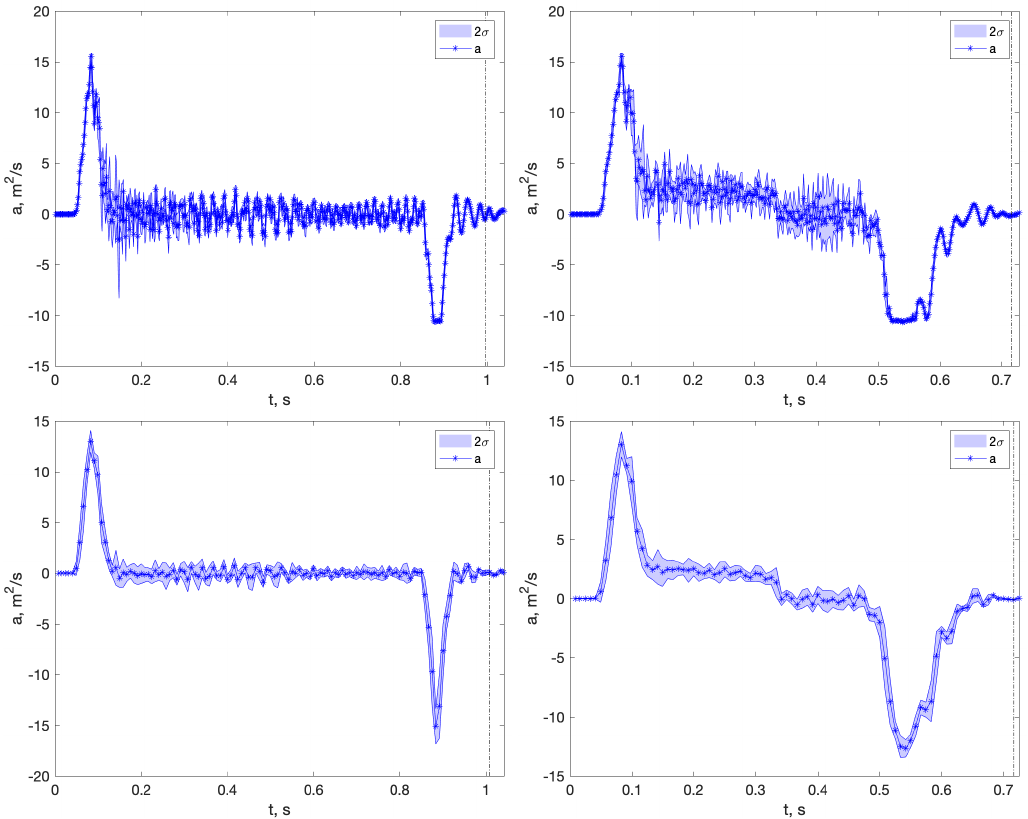
Figure 8. Average accelerometry profile of Accel.WR ( first row ) and Accel.XS ( second row ), with a band corresponding to two standard deviations. ( Left ) Experiment 7 at 50 cm/s. ( Right ) Experiment 8 at 100